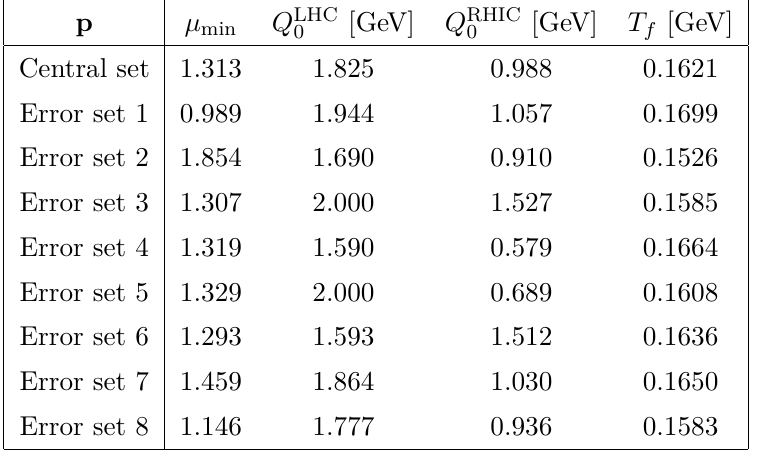
Table 1 . Parameter sets for central prediction and error estimation. They are determined from the posterior probability distribution of parameters using a procedure described in the